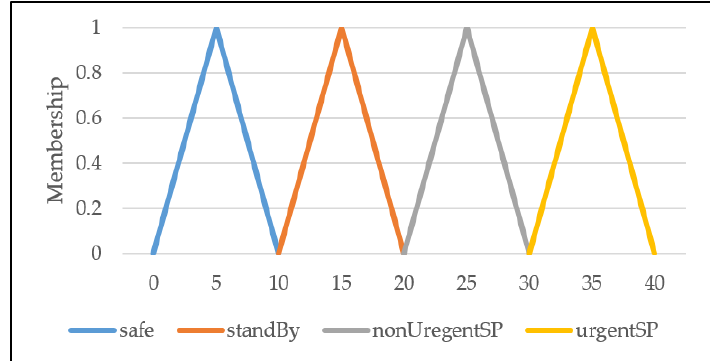
Figure 9. Fuzzy value range for decision of placement.